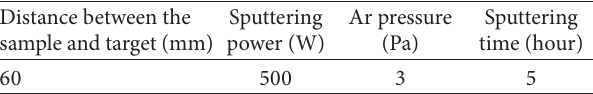
Figure 2: XRD pattern of the interlayer prepared by pack cementa- Sputtering Ar pressure Sputtering power (W) (Pa) time (hour)